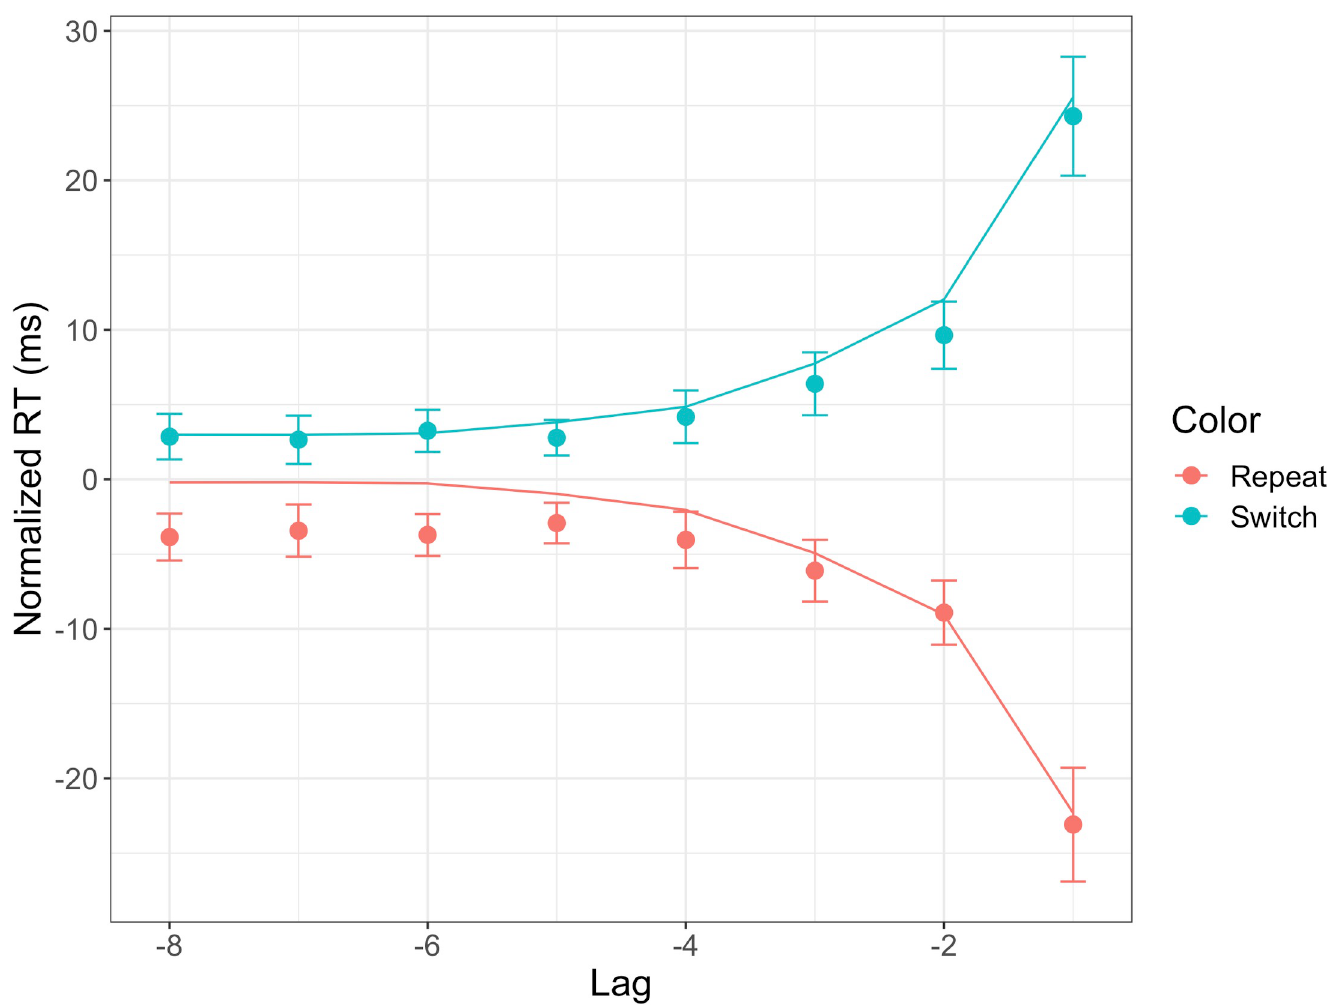
Fig 9. Temporal profile of the color-based inter-trial effects. Mean normalized RT for repeated vs. switched target color on (current) trial n compared to (preceding) trial n-1 (lag 1), n-2 (lag 2) up to n-8 (lag 8). Normalized RTs were first averaged across the two sessions for each participant; the resulting (individual mean normalized) RTs were then used to compute the overall means and confidence intervals, across participants. Filled circles depict the behavioral data, lines the model predictions. Error bars represent 95% confidence intervals.